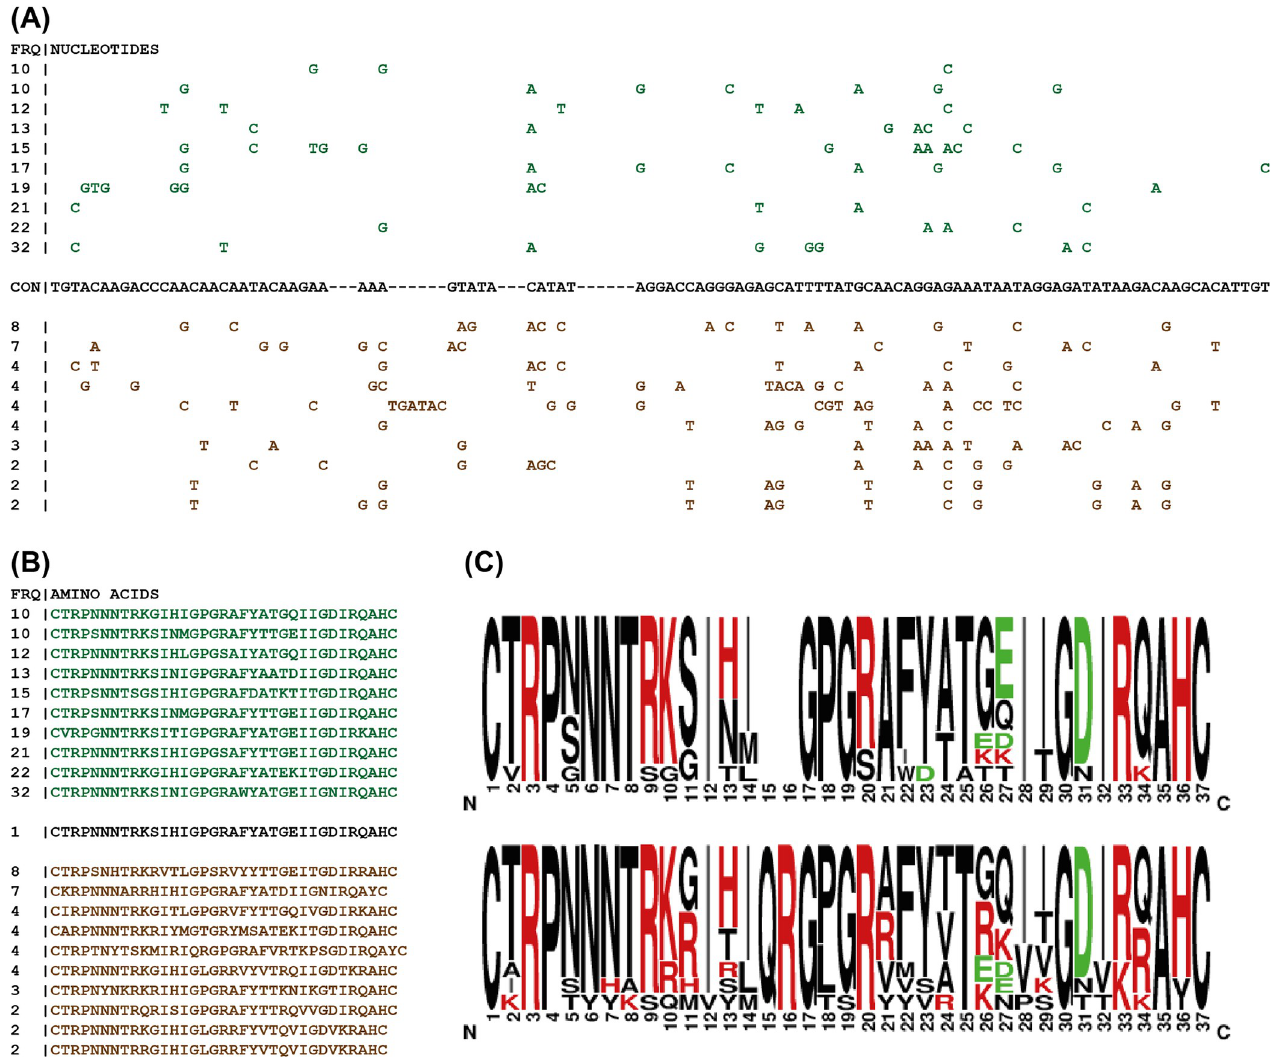
Fig 4. Summarization of variation present within the V3 loop. (A) Green residues represent non-consensus residues from the ten most frequent variants associate with the CCR5-using phenotype. Brown represents those of the CXCR4-using phenotype. The consensus sequence (black) is shown. (B) Translations of the most frequent ten variants from each phenotype. (C) Sequence logos summarizing these translations. The top logo is from represents the CCR5-using sequences whilst the bottom represents the CXCR4-using